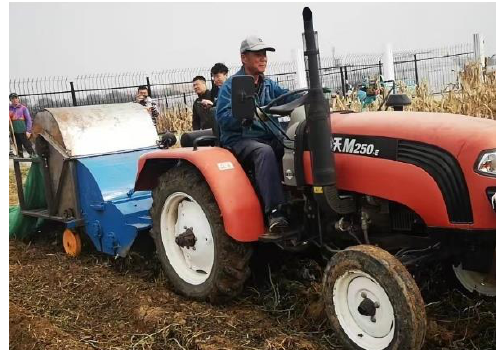
Figure 9. Test on double-roller sweet potato vine crushing and collecting.